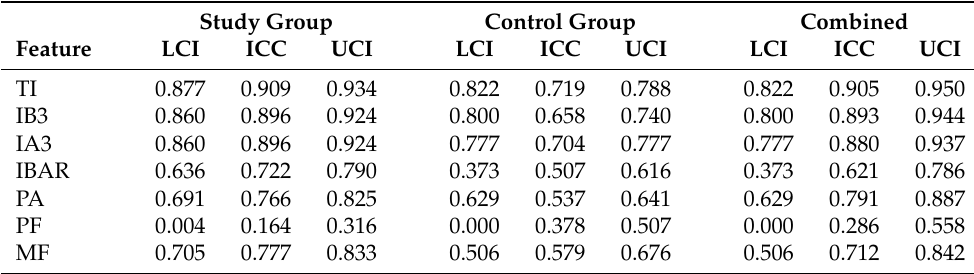
Table A3. Intraclass correlation coefficients (ICC) for each feature computed on norm2 -normalized spectrum with corresponding 95% confidence intervals (CI).